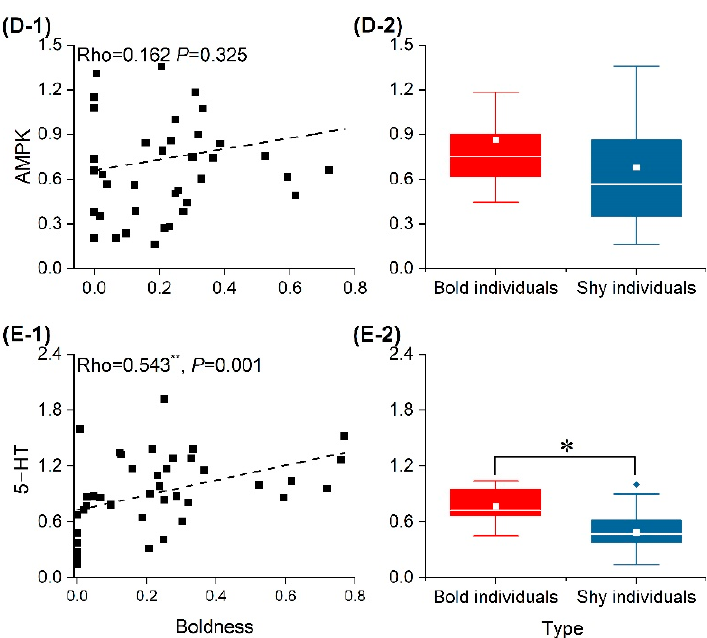
Figure 6. Correlation analysis between boldness and mRNA relative expression levels of Na+/K+- ATPase ( A-1 ), NADH ( B-1 ), CCO ( C-1 ), AMPK ( D-1 ), and 5-HT ( E-1 ) in cheliped muscle, and differences in mRNA relative expression between bold and shy individuals ( A-2 , B-2 , C-2 , D-2 , E-2 ). Note: The white line represents the median boldness within the group, and the white rectangle represents the mean boldness within the group. Asterisk represents significant differences between groups (“*”: p < 0.05; “**”: p < 0.01). The diamonds represent outliers in the data.